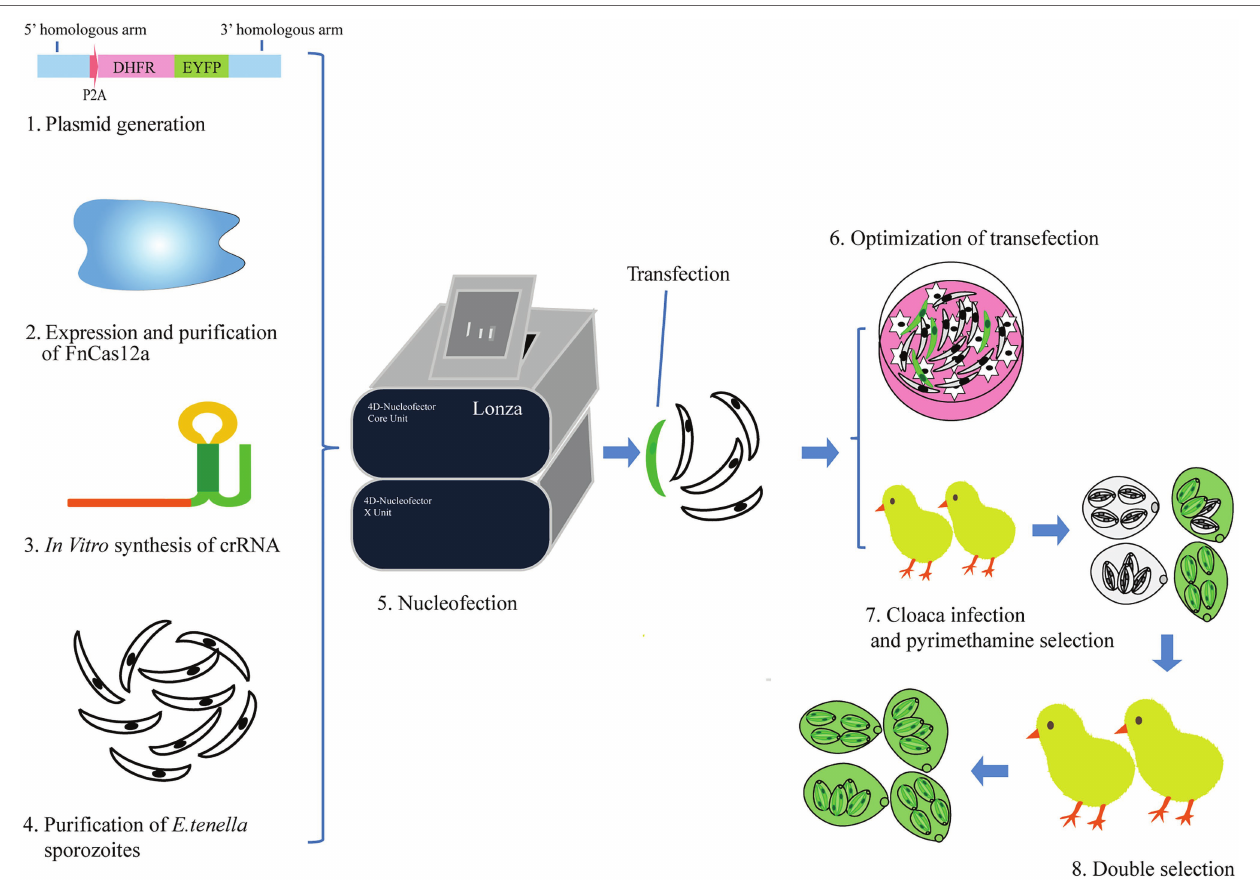
FIGURE 1 | The diagram for genetic manipulation of FnCas12a/crRNA-mediated genome editing in E. tenella . (1) The generation of plasmids used as homologous recombination template. (2) Expression and purification of FnCas12a proteins. (3) crRNA synthesis in vitro . (4) The purification of E. tenella sporozoites. (5) E. tenella sporozoites were transfected with FnCas12a protein, crRNA with or without homologous recombination template using Lonza 4D-Nucleofector. (6) Sporozoites (2 × 10 6 ) were cultured in PCK cells to show transfection results. We also used this step to compare the transfection efficiency of different nucleofector programs. (7) The remaining part of sporozoites (8 × 10 6 ) was inoculated in chicken via cloaca and selected with pyrimethamine in feed. The progeny oocysts were harvested from feces 6–10 days after inoculation. (8) The progeny oocysts infected new batches of chickens (coccidia-free) by oral gavage. Pyrimethamine was used to enrich for parasites carrying the DHFR